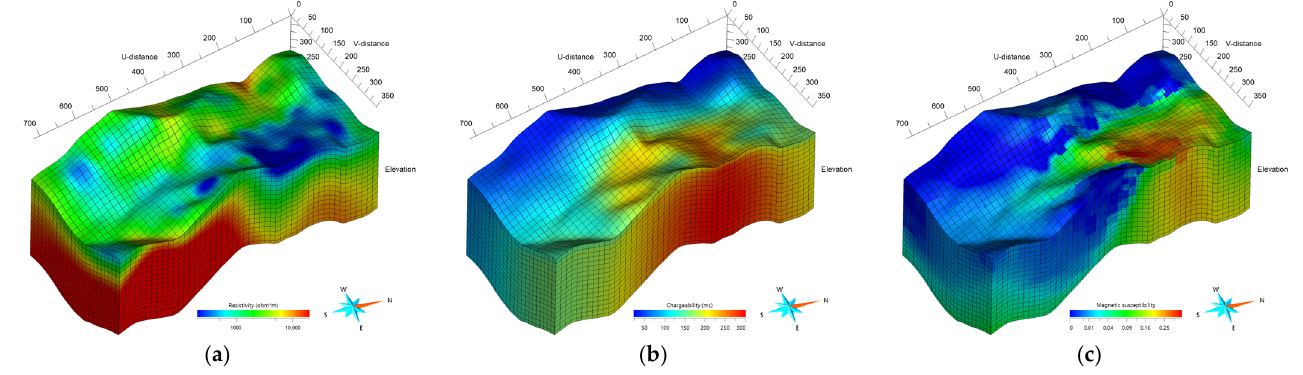
Figure 6. The 3D inversion results from the geophysical field survey: ( a ) electrical resistivity, ( b ) chargeability, and ( c ) magnetic susceptibility.